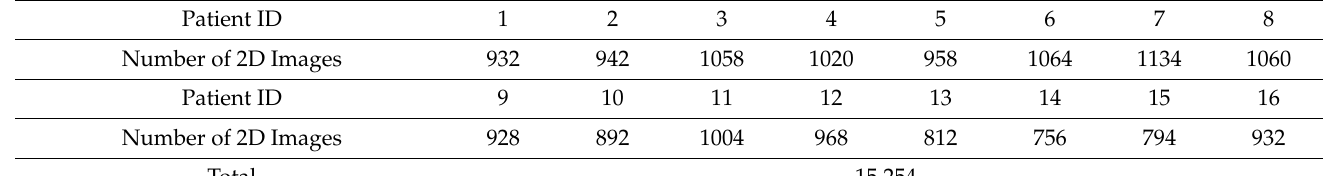
Figure 7. Examples of images with corresponding ground-truth thyroid region in 3DThyroid dataset. Table 2. Details of the TDID dataset .